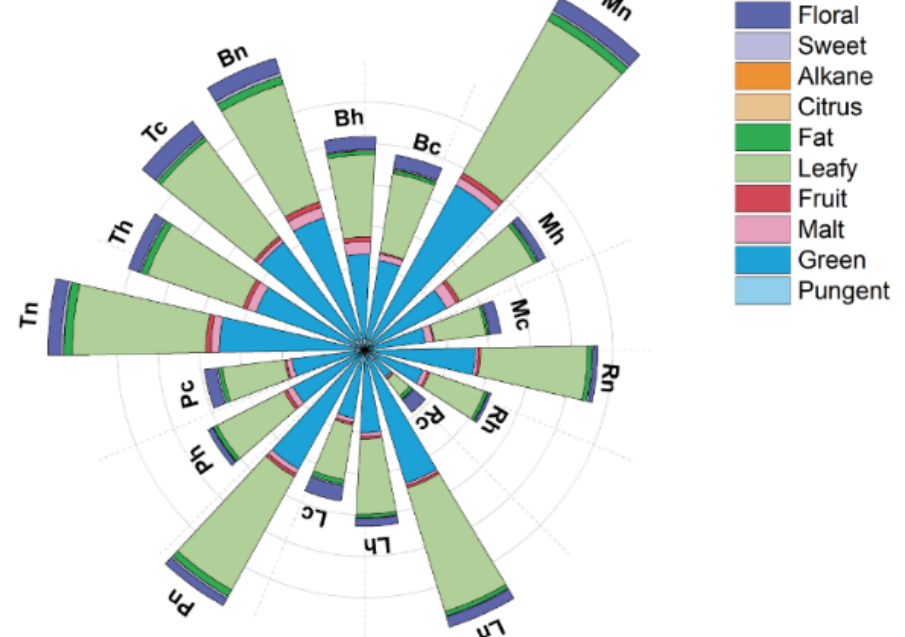
Figure 6. Effects of different treatment combinations of harvest maturity and temperature on aromatic volatiles by reported flavor sensory property (see Table 2). Abbreviations represent combinations of harvest maturity (R—red; L—light red; P—pink; T—turning; B—breaker; and M—mature green) and temperature treatment (h—heating; c—chilling; n—non-treated control).